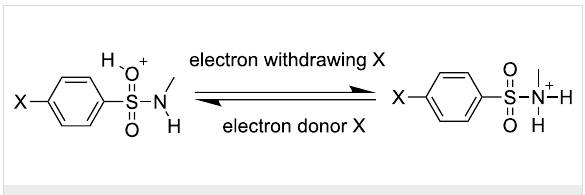
Still, a possibility that should not be discarded is the existence of a tautomeric equilibrium between the N - and O - protonated structures, the latter having a greater relevance for the sulfon- amides with electron-donor groups (Scheme